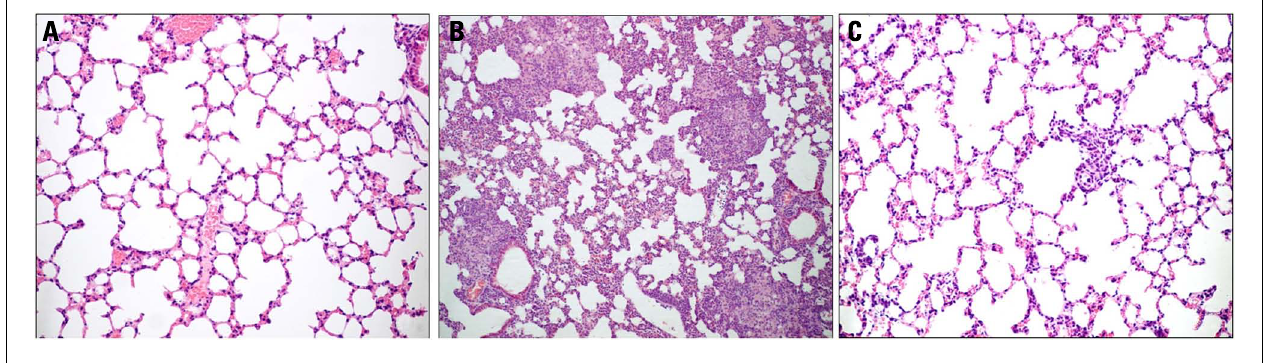
lesions in the lungs, with epithelioid granulomas surrounding a large number of yeast cells. Infected mice treated with ArtinM present no granulomas, and lung architecture is similar to that of uninfected mice.The lung sections were stained with H&E (Modified from Coltri etal., 2010).